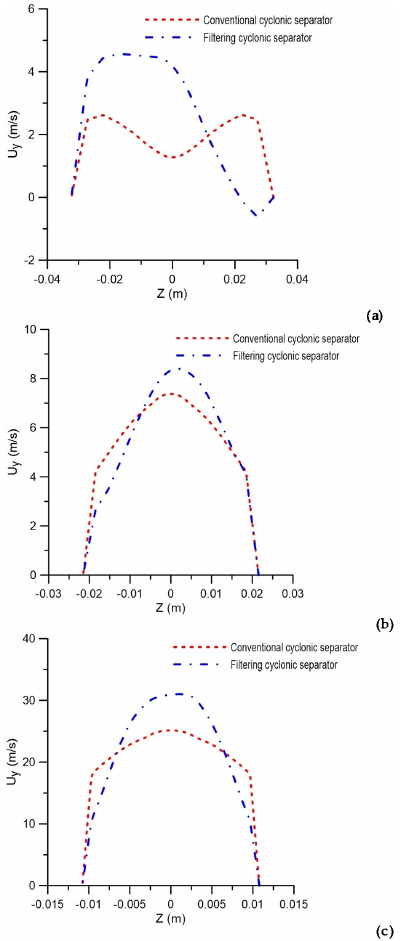
Figure 10. Axial velocity profile in the conventional and filtering hydrocyclones at the positions ( a ) y = 0.15 m, ( b ) y = 0.45 m and ( c ) y = 0.75 m.